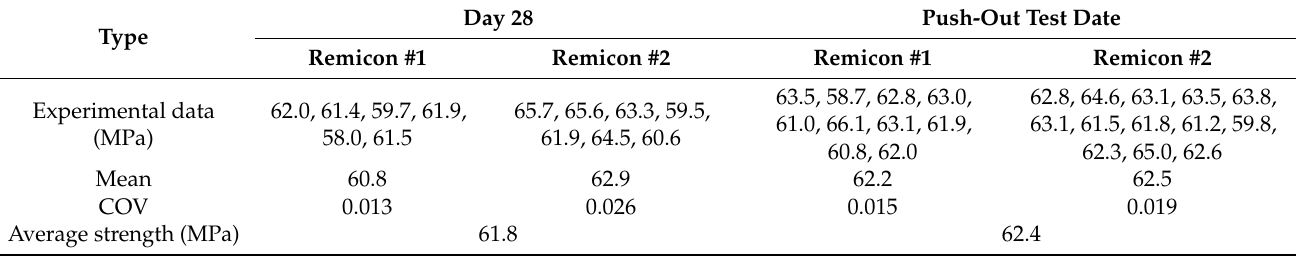
Table 3. Concrete compressive strength.